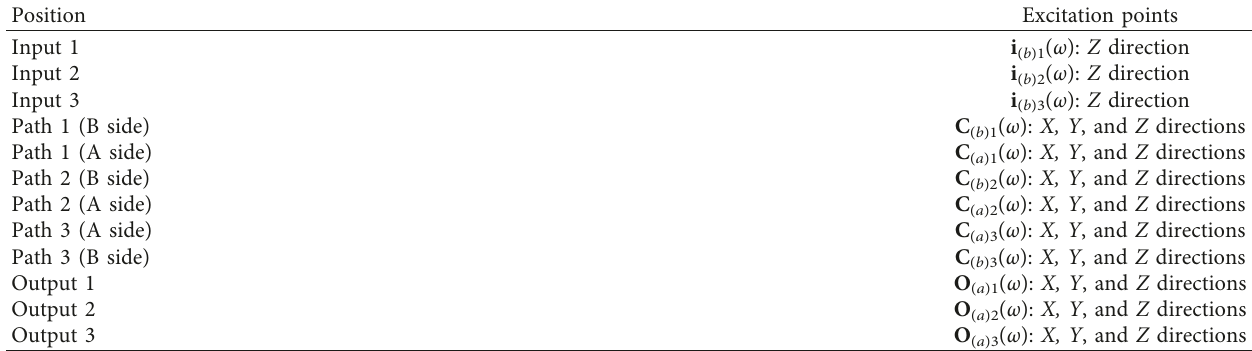
Figure 7: Response points (a) O ( a )3 ( ω ), (b) O ( a )2 ( ω ), and (c) O ( a )1 ( ω ) in the Z direction under same load. Red curve indicates the new time- domain substructure IMTPA M-2, green curve means conventional substructure obtained using inverse matrix method M-1, and blue curves represent the vibrations tested in this facility. Table 4: Input, output, and path points.